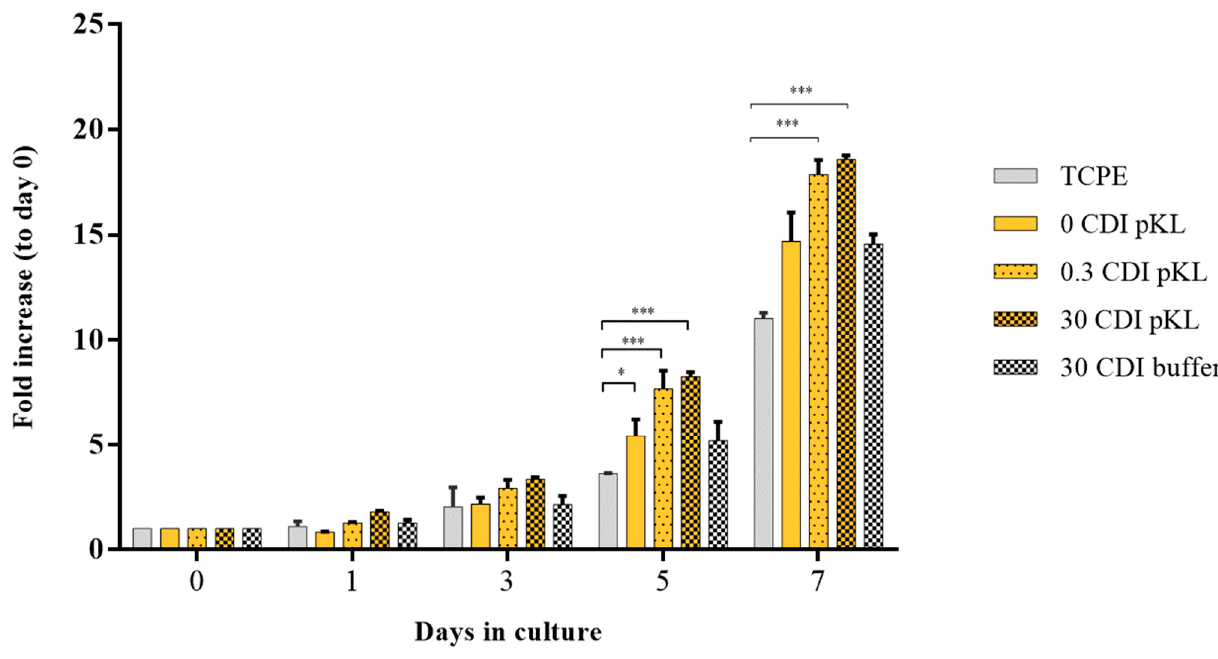
Figure 4. hMSC metabolic activity on pKL-SAMs and buffer-SAMs. Cells metabolic activity during 7 days in culture as index of cell growth. Data are expressed as average ± STDEV of three replicates per condition. * Statistically significant difference as compared to TCPE surface (* p < 0.05; *** p < 0.001) .